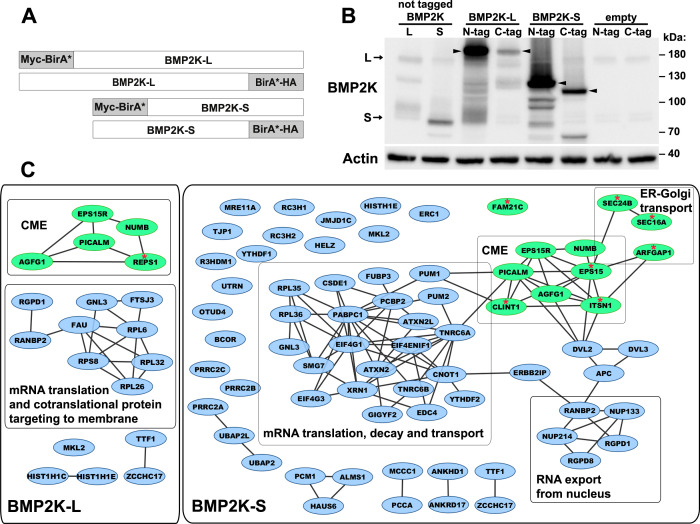
Proximity biotinylation (BioID) analysis of BMP2K-L or -S interactomes.(A) Schematic representation of fusion proteins that were ectopically expressed in HEK293 cells for the purpose of the proximity biotinylation (BioID) analysis. (B) Western blots showing transient expression in HEK293 cells of BMP2K-L or BMP2K-S, N- or C- terminally tagged with BirA* biotin ligase as well as non-tagged L or S isoforms. Bands representing the full-length proteins are indicated by arrows (for non-tagged L and S isoforms) or arrowheads (for BirA*-tagged proteins). Actin was used as a gel loading control. (C) Cytoscape diagrams (www.cytoscape.org) showing interactions between proteins detected in BioID as proximal to BMP2K-L or -S isoforms with indications of functionally related protein groups (CME – clathrin-mediated endocytosis). Green color indicates known regulators of vesicular trafficking. Red asterisks mark vesicular trafficking-related proteins detected as proximal to only one of the isoforms.